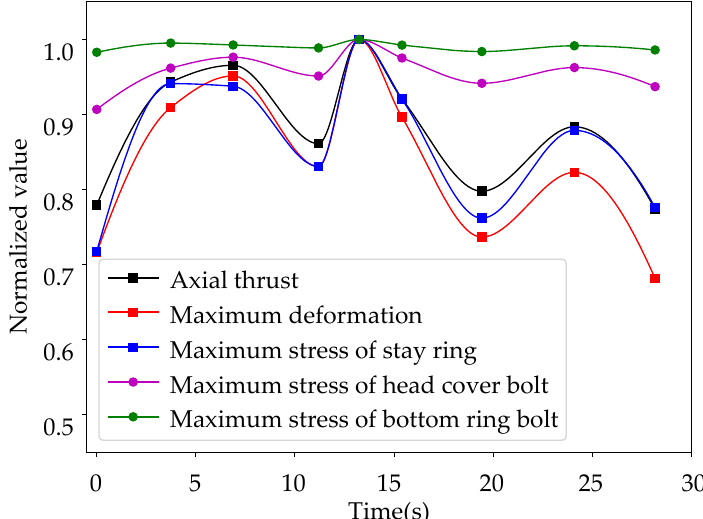
Figure 21. Results’ comparison of the PT unit during load